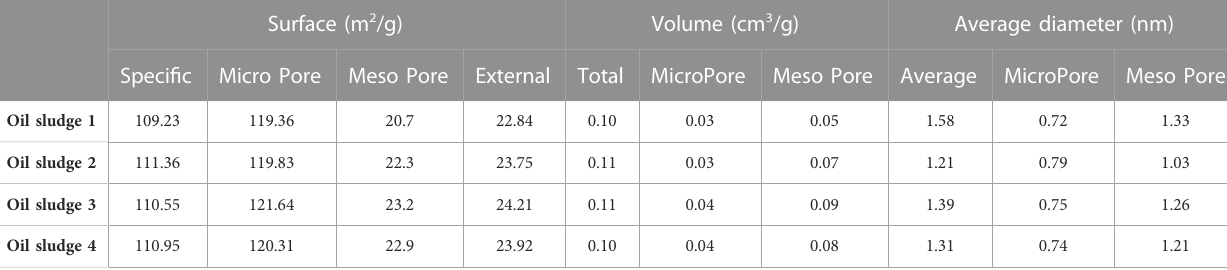
TABLE 2 The surface characteristics and the pore structure of the prepared activated carbon using different types of oil sludge.